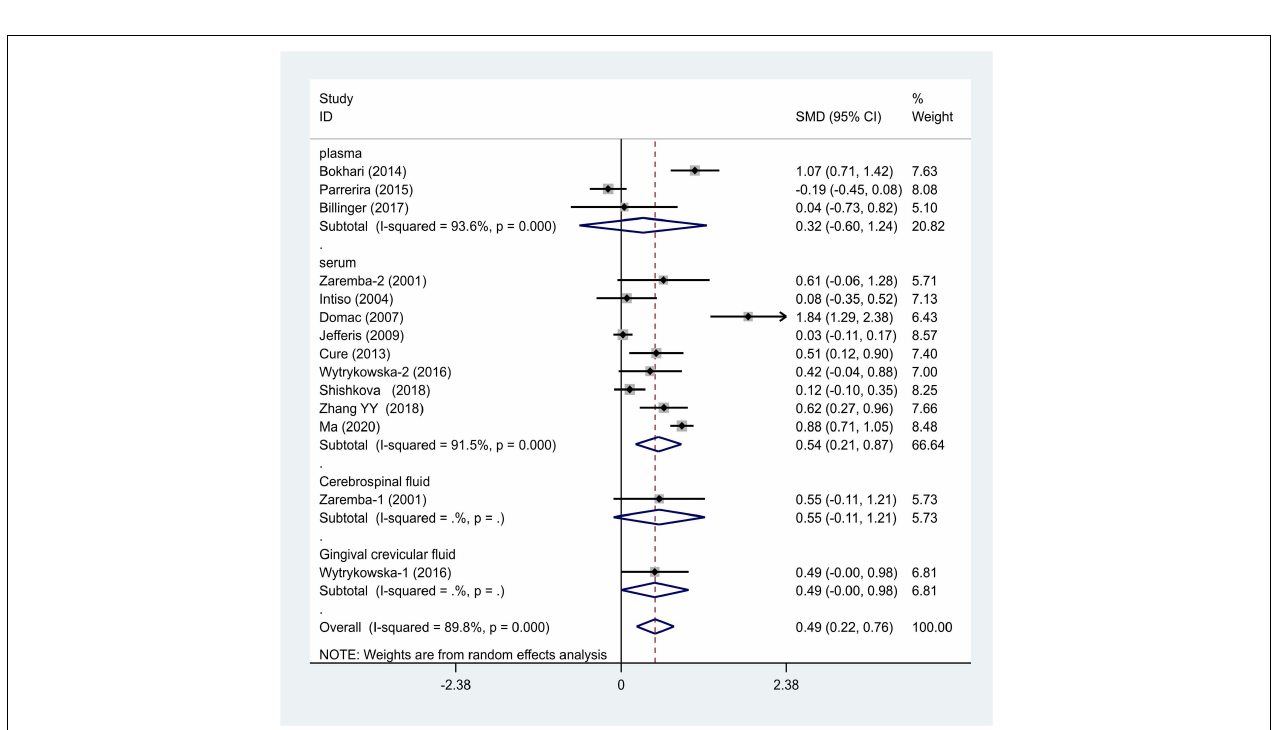
FIGURE 5 | Results of the random-effects meta-analysis for the TNF- α G308A allele (G vs. A) in Caucasian, Asian, IS, and control groups, respectively.